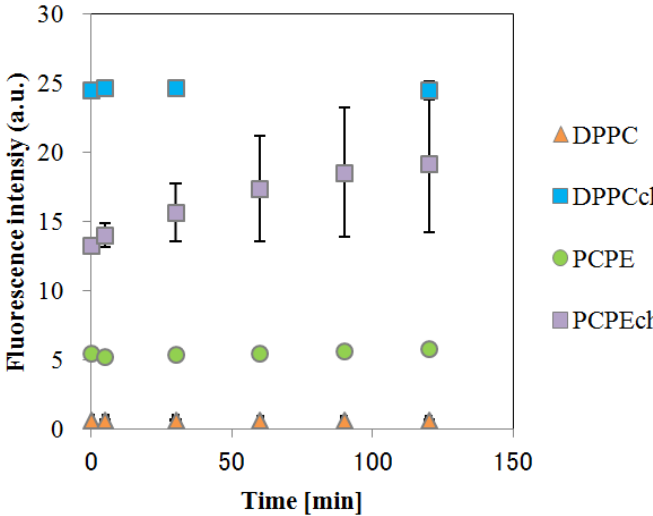
Figure 3. Temporal fluorescence changes of the CF-liposome. All of plots are an average of three samples. The error bars indicate standard